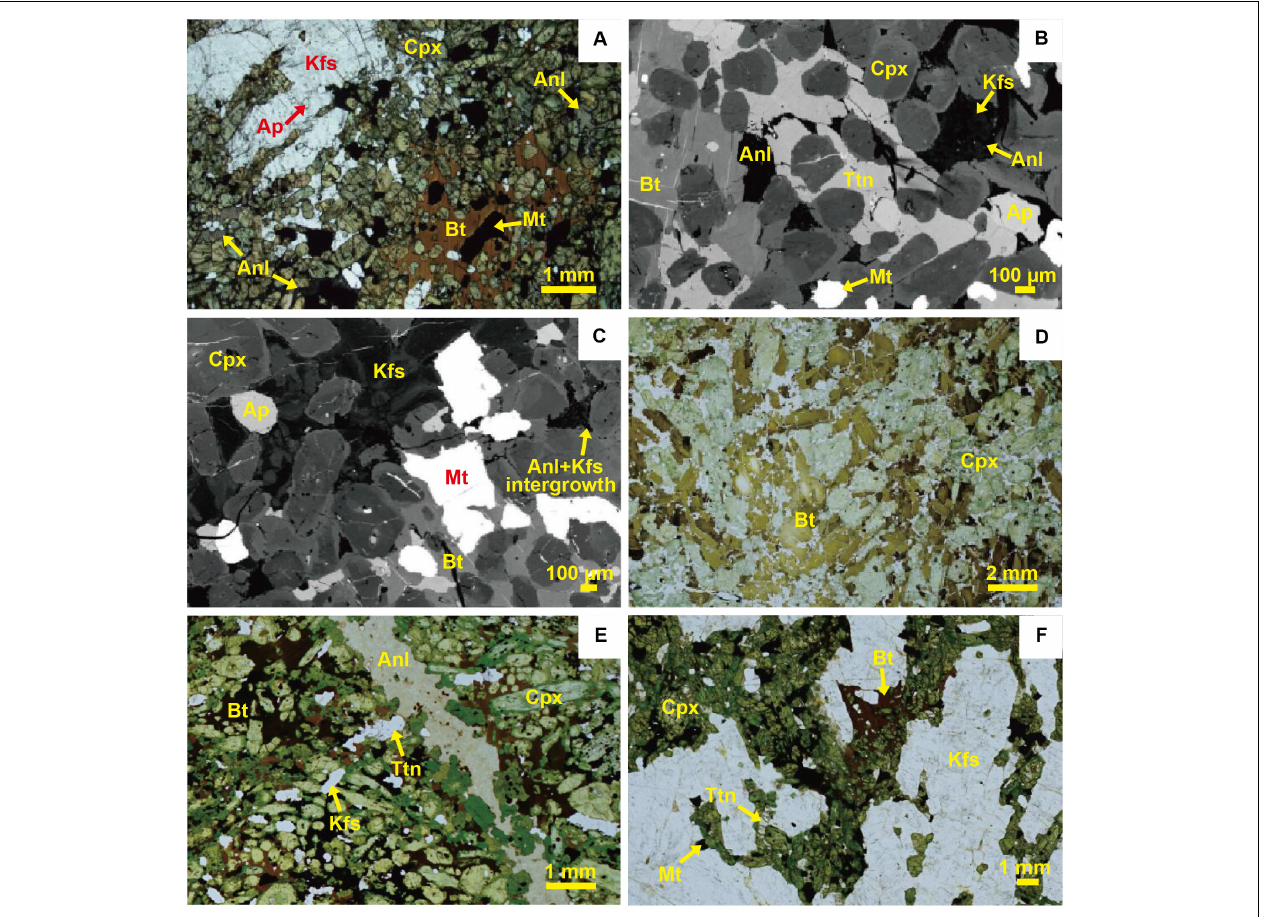
FIGURE 3 | Microphotos of clinopyroxenite. (A) Poikilitic texture with zoned clinopyroxene chadacrysts and biotite and K-feldspar oikocrysts (plane-polarized light). (B) Titanite oikocrysts (Back-scattered electron, BSE, image); There are also micro co-existing K-feldspar and analcite at the upright part of the picture. (C) Zonation of K-feldspar oikocryst, and there are micro co-existing K-feldspar and analcite at the upright part of the picture (BSE image). (D) Glimmerite (scanned photo of thin section). (E) A vein filled by analcite (scanned photo of thin section). (F) K-felspar clinopyroxenite showing poikilitic texture in the interstices between K-feldspar grains (scanned photo of thin section). Ap, apatite; Anl, analcite; Bt, biotite; Cpx, Clinopyroxene; Kfs, K-feldspar; Mt, Magnetite; Ttn,